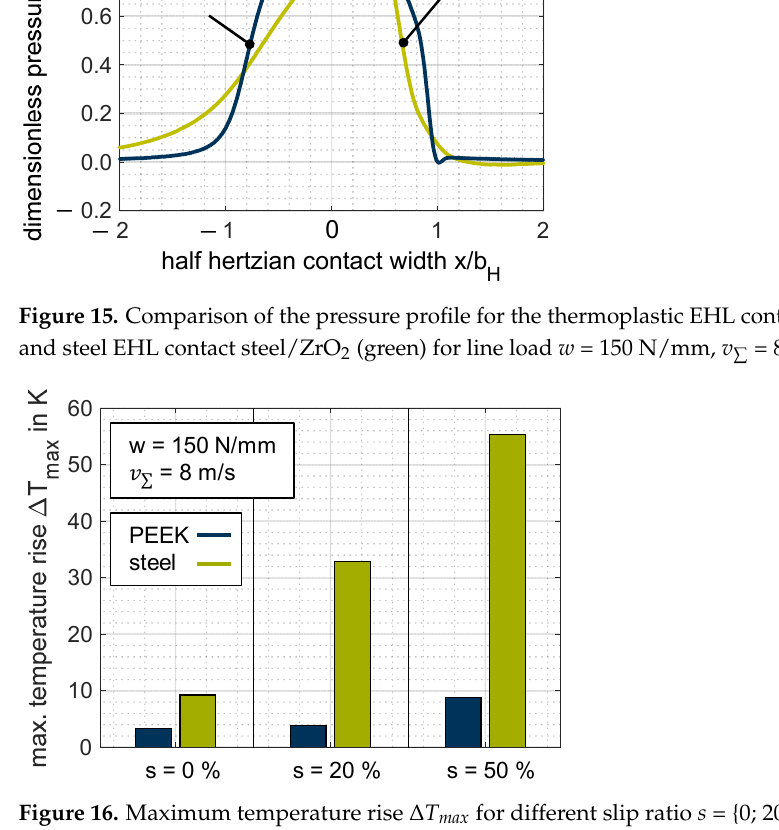
Figure 16. Maximum temperature rise ∆ T max for different slip ratio s = {0; 20; 50}% for the thermo- plastic EHL contact ZrO 2 /PEEK and steel EHL contact ZrO 2 /steel (line load w = 150 N/mm, sum velocity v ∑ = 8 m/s, oil temperature ϑ oil = 30 ◦ C, MIN100).